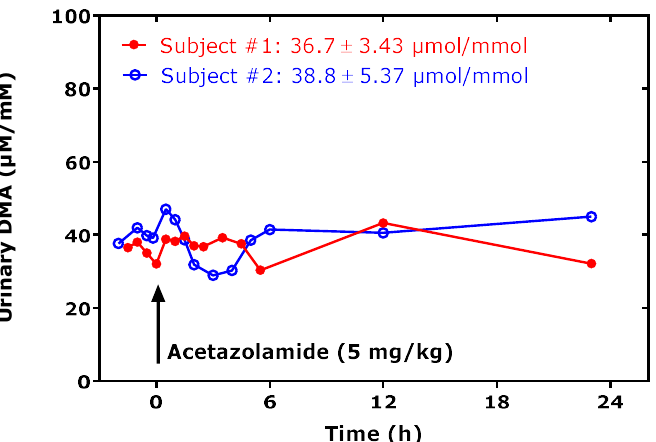
Figure 3. Creatinine-corrected excretion rate of dimethylamine (DMA) in urine spot urine samples collected by two healthy subjects at the indicate time points, before and after ingestion of an acetazolamide tablet (indicated by the arrow), at the dose of approximately 5 mg / kg bodyweight. The DMA excretion rate varied by 9% in subject # 1 and by 14% in subject # 2 over about 24 h.